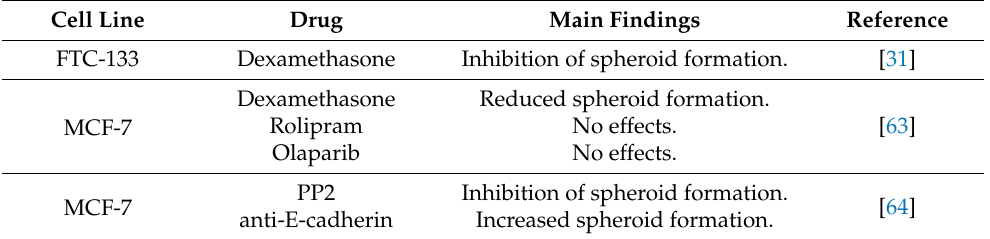
Table 1. Other studies on targeting RPM-induced spheroid formation of cancer